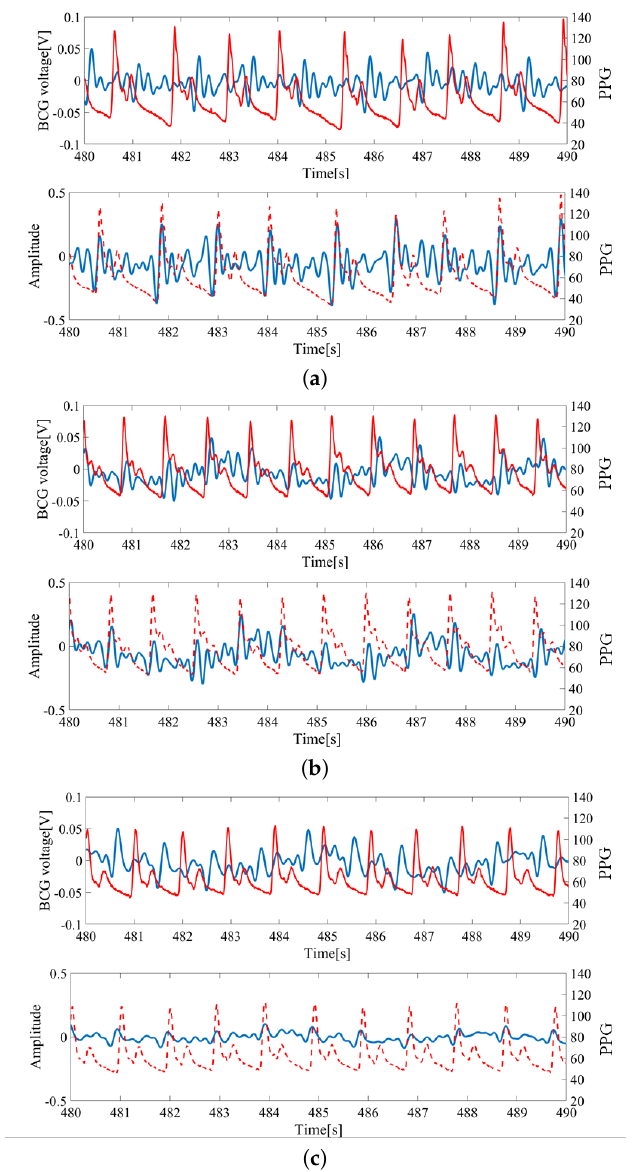
Figure 9. HRV extraction from the BCG; ( a ) sub1 (age: 30 s, height: 175 cm, weight: 59 kg, BMI 19.3). ( b ) sub5 (age: 20 s, height: 156 cm, weight: 52 kg, BMI 21.4). ( c ) sub14 (age: 30 s, height: 178 cm, weight: 90 kg, BMI 28.4). The blue line corresponds to raw data and preprocessed BCG data. The red line corresponds to finger